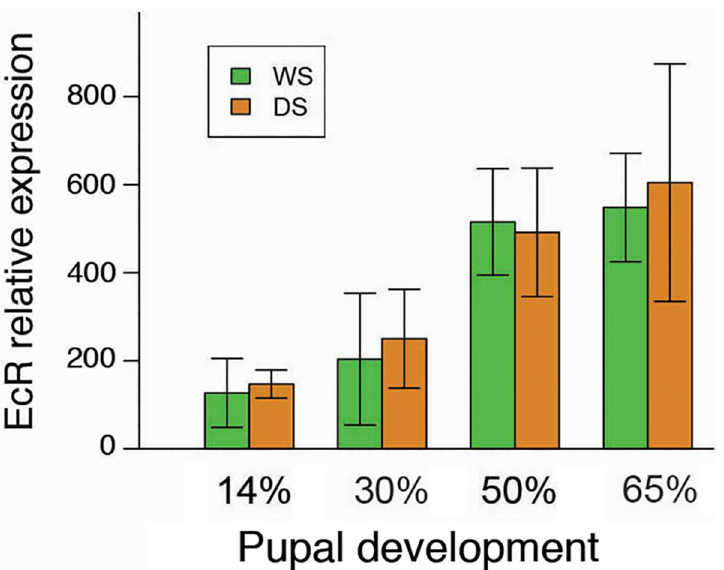
Fig 2. Ecdysone receptor expression in the brain is similar in pupal WS and DS B. anynana males. T- test performed on qPCR results show that there are no significantdifferences in EcR expressionin the brains of B . anynana male pupaereared at WS and DS temperatures during14%, 30%, 50%, and 65% of pupal development. Error bars correspond to 95% confidenceintervals for the means. p = 0.825), or at 50% of pupal development (rearing temperature: F = 8.567, p = 0.004; treat- 3,83 ment: F = 0.014, p = 0.906; interaction: F = 2.793, p = 0.098) (S1 Fig). 3,83 3,83